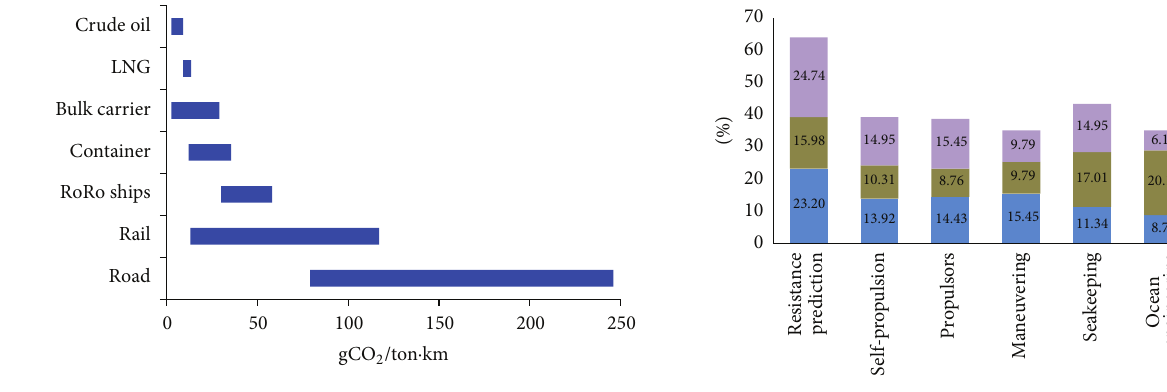
Figure 1: Ship CO 2 emissions comparison to rail and road.